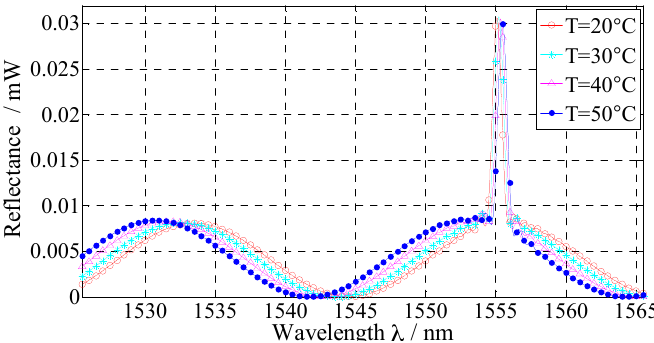
Figure 2. Simulation of the output spectrum under different temperatures (H = 0).